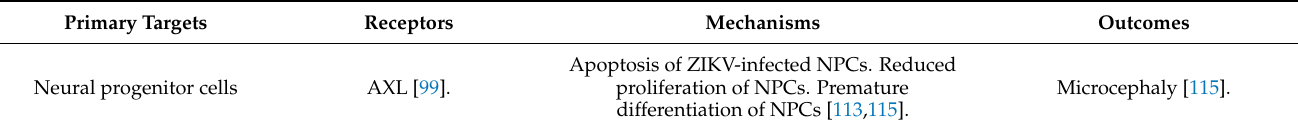
Table 3. Pathological mechanisms and manifestations of ZIKV